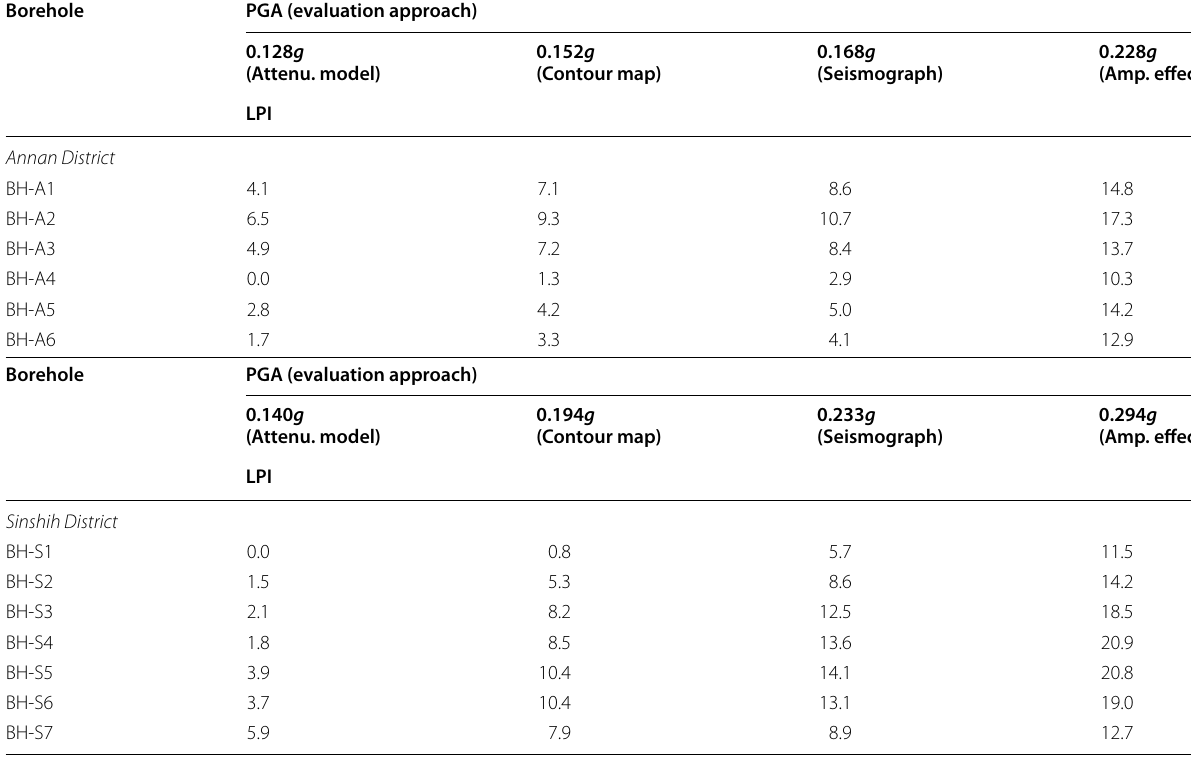
Table 6 The evaluated LPI subject to the PGAs evaluated by different approaches